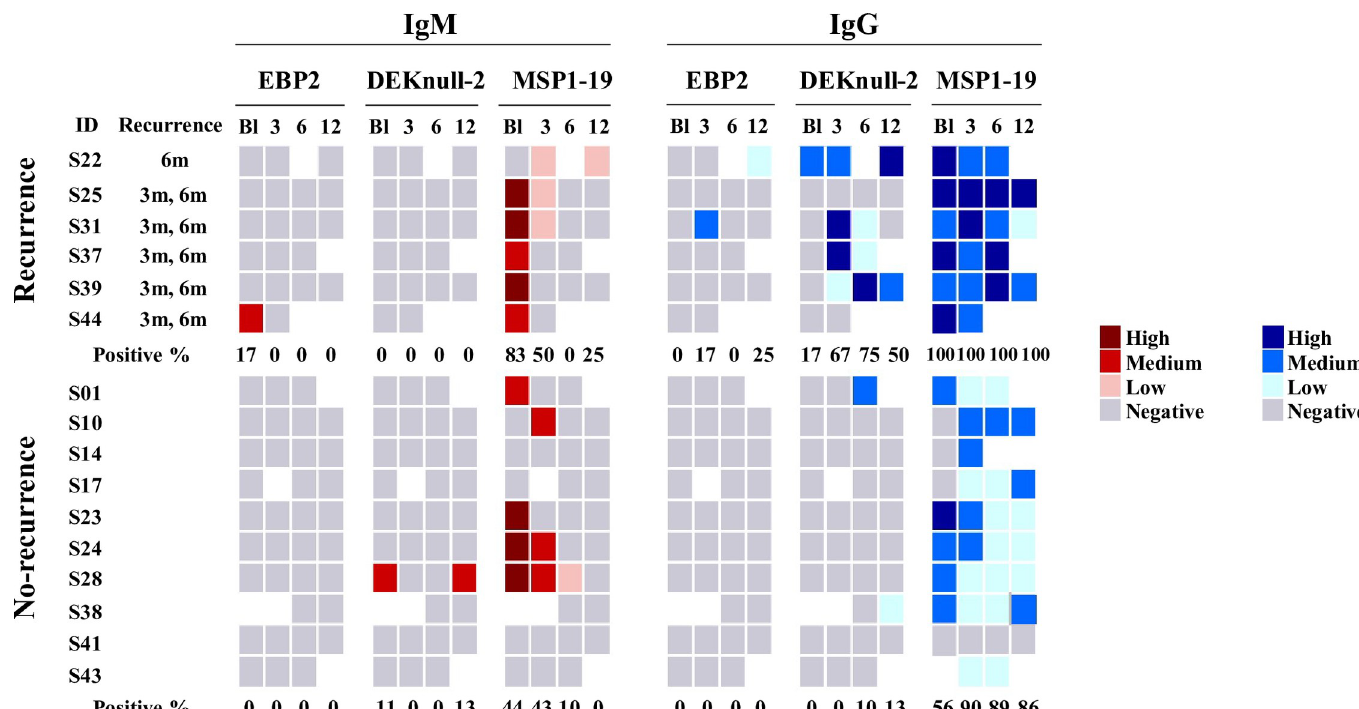
Fig 4. Influence of recurrence on the IgM and IgG responses to distinct P . vivax vaccine candidates. Individuals who experienced first P . vivax malaria infection (Cases) were grouped into: (i) Recurrence (n = 6)–individuals who experienced one or two additional recurrent P . vivax infection; and (ii) No-recurrence (n = 10)– individuals who did not have additional blood-stage P . vivax infection. IgM (red) and IgG (blue) antibodies responses to EBP2, DEKnull-2 and MSP1-19 were measured by ELISA at baseline (BL), 3, 6, and 12-month after the outbreak. The color gradient indicates the intensity of IgM (red) and IgG (blue) antibody levels categorized by tercile in High (Upper tercile), Medium (Second tercile) and Low (First tercile) for each protein and parasitemia (orange) according to parasitemia range. The time points of follow-up study and recurrent P . vivax infection moment were indicated at the heatmap.